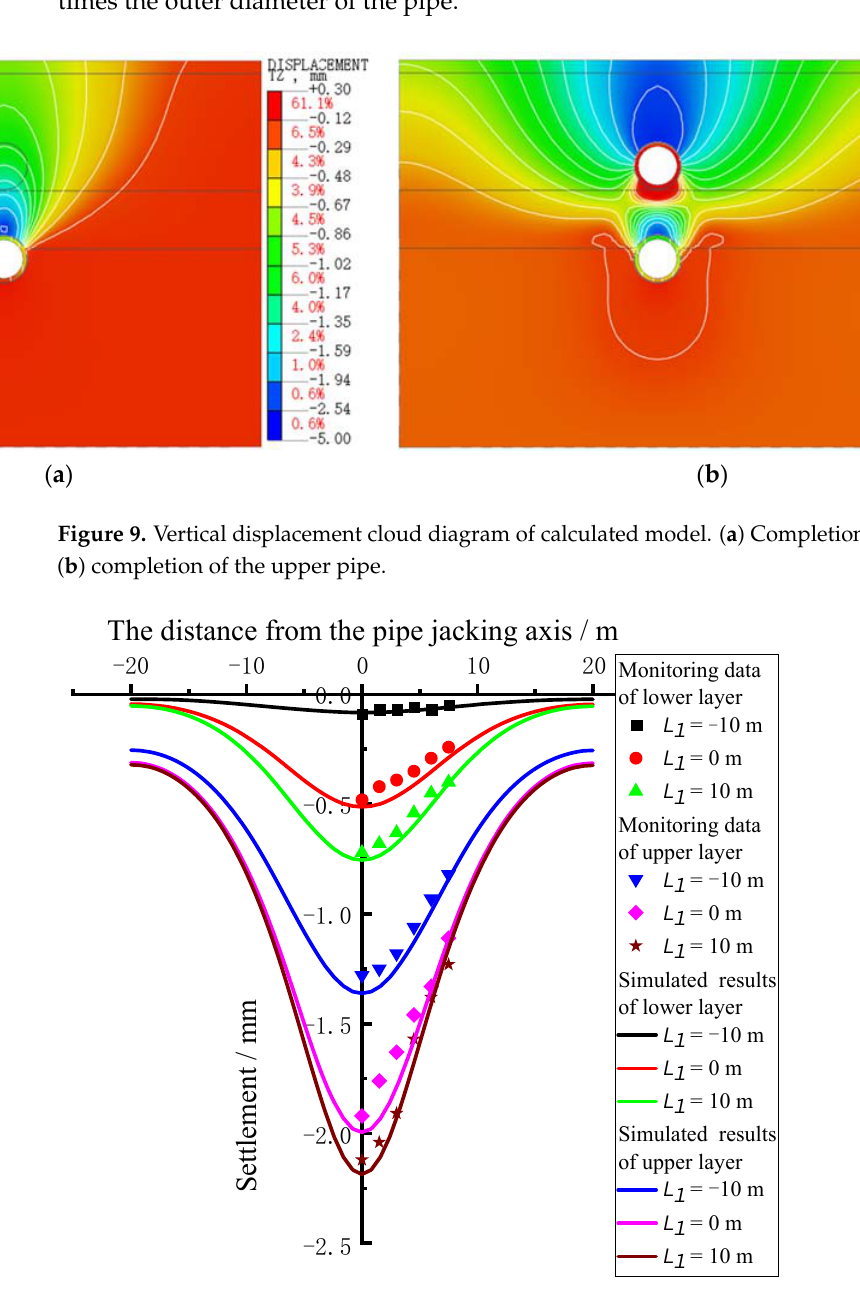
Table 2. Empirical values of nonlinear stiffness parameters of the modified Mohr-Coulomb consti- tutive model.